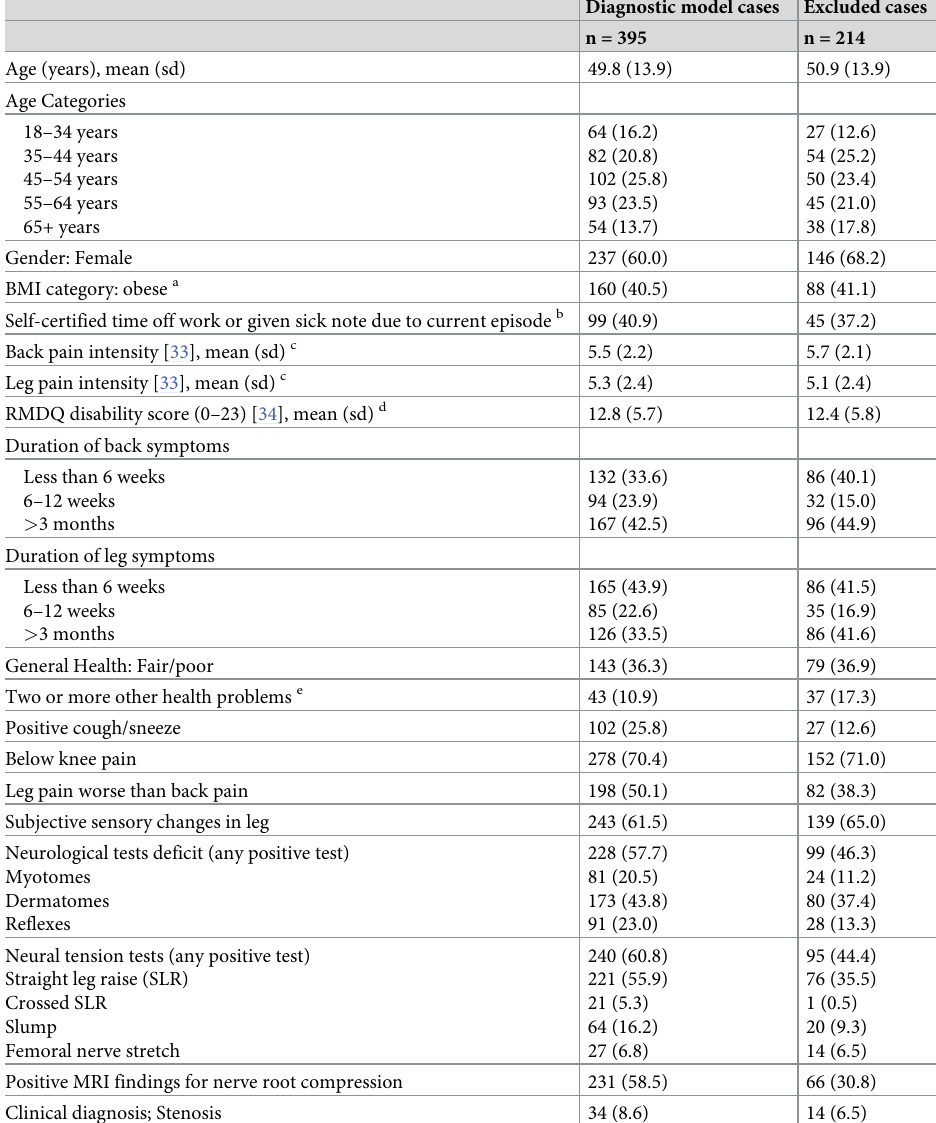
Table 1. Characteristics of patients eligible and ineligible for diagnostic model development